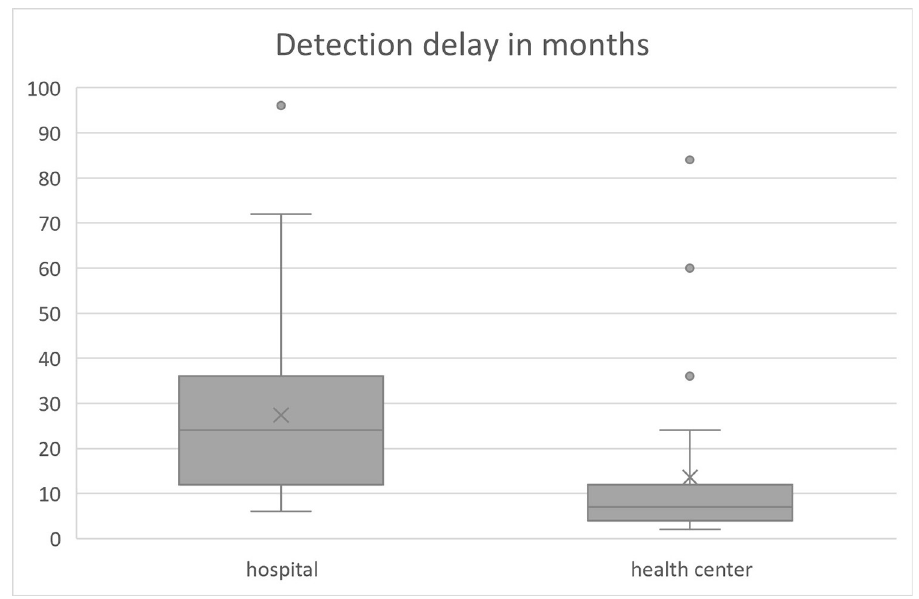
Fig 1. Patient median delays in diagnosis among leprosy patients in East Hararghe Zone, Eastern Ethiopia, January and February 2019.